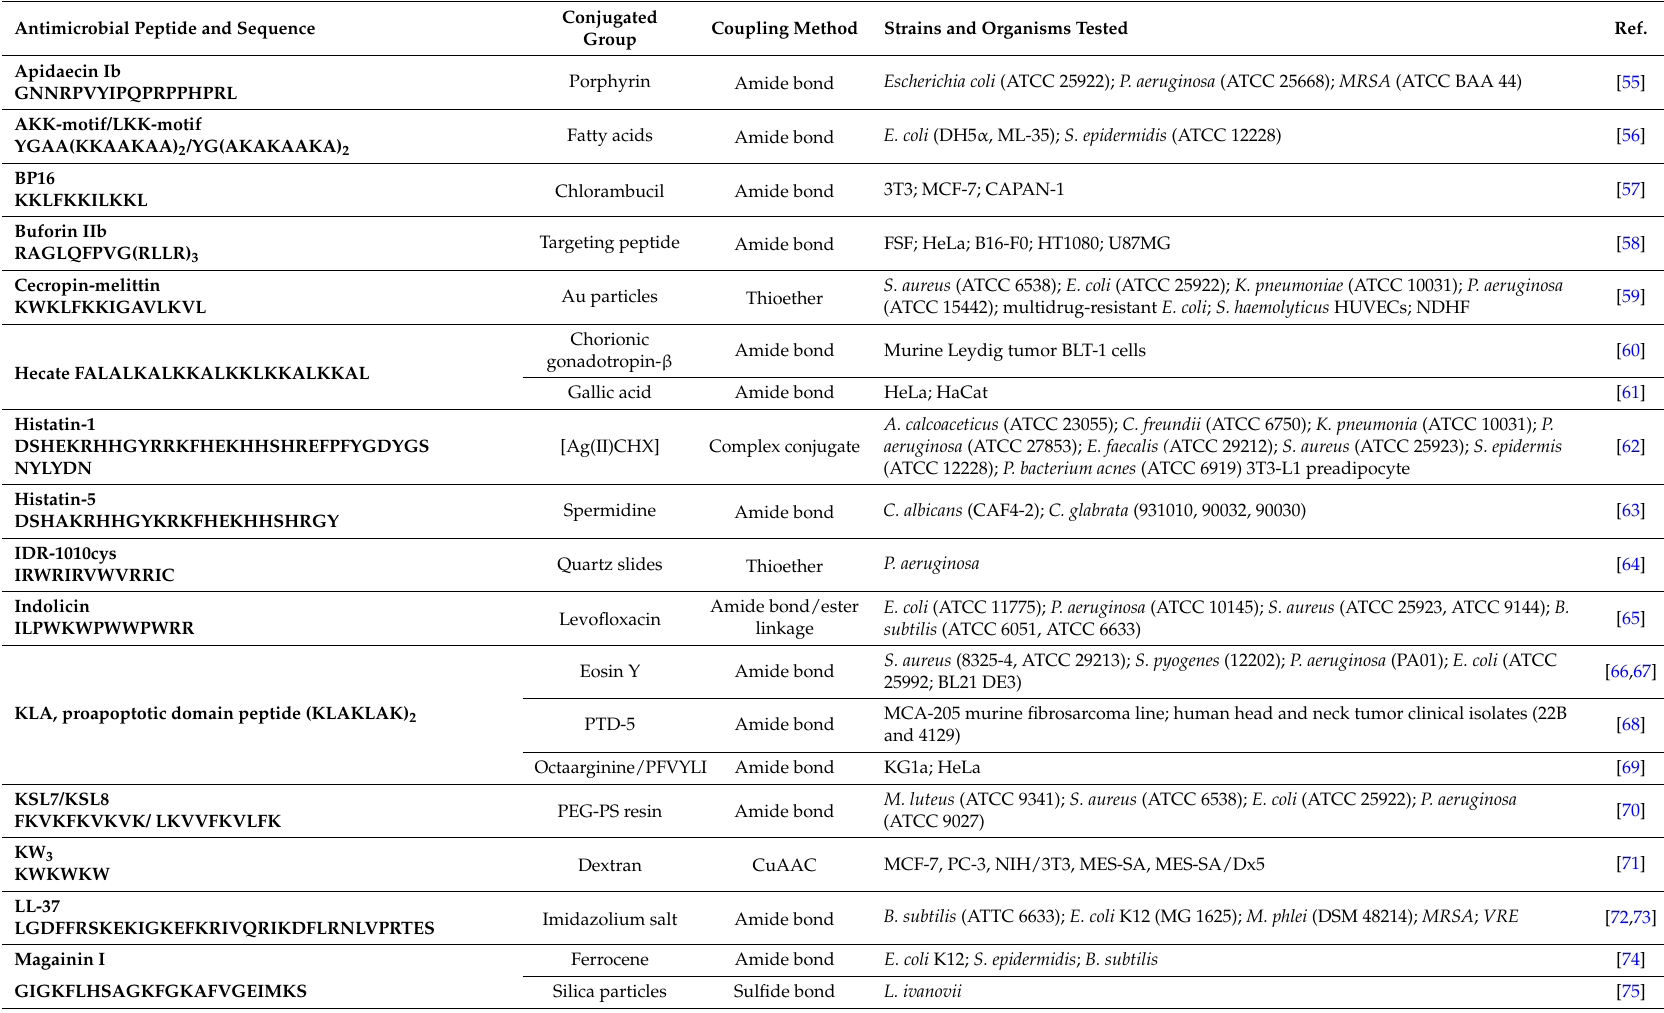
Table 1. Overview of AMP conjugates discussed in this study. AMPs are listed in alphabetical order. Antimicrobial Peptide and